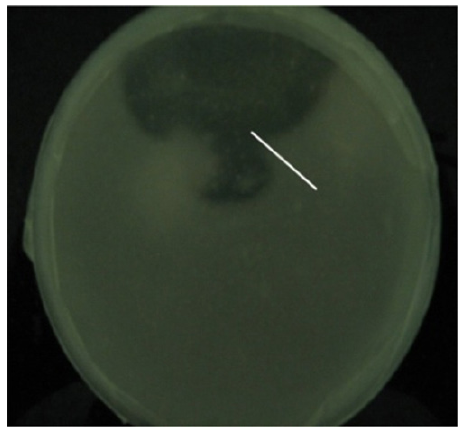
Fig. 1. Screening plate showing large transparent area formed after dissolution of calcium